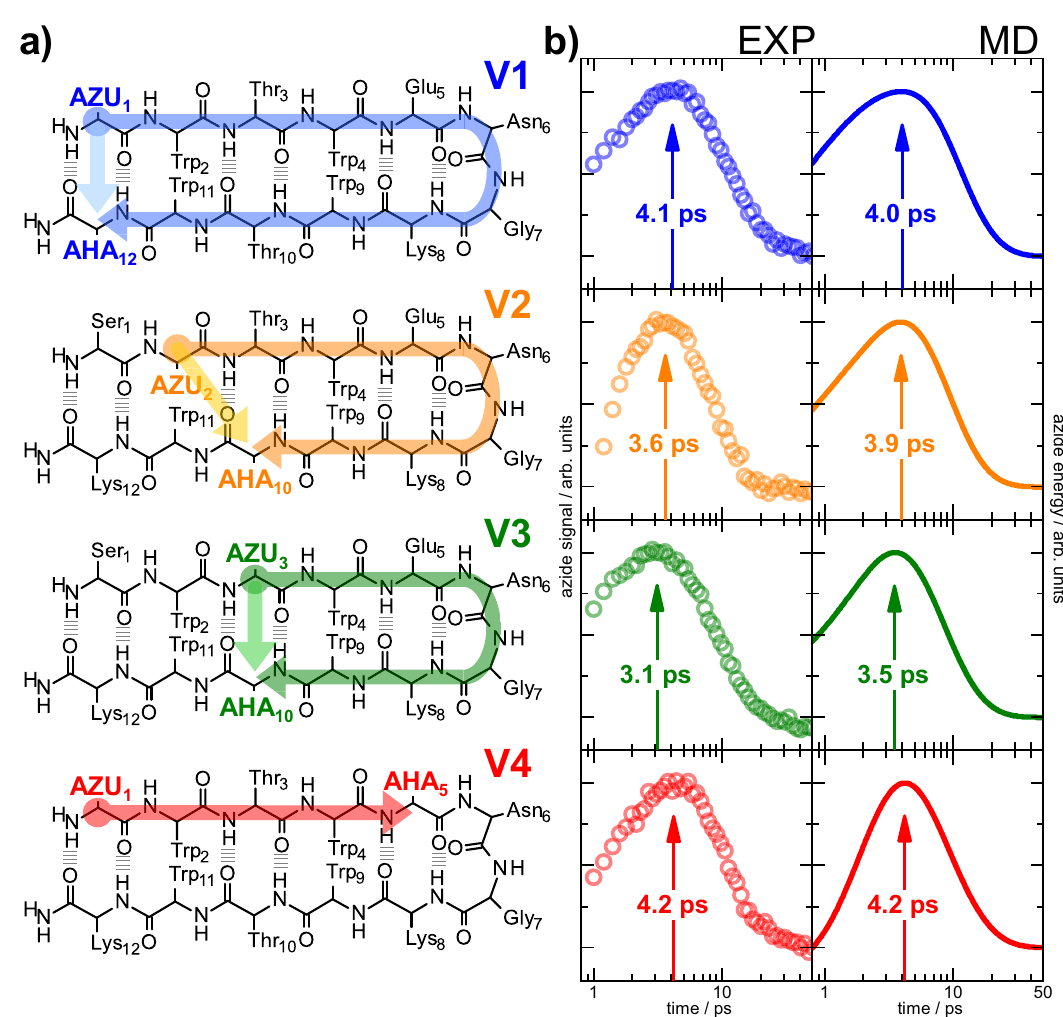
Fig. 2 Overview of the TrpZip2 variants and their measured and computed VET signals. a Scheme of our four TrpZip2 variants V1 – V4. The systematically varied positions of VET donor-sensor pairs in peptide scaffolds are highlighted with the corresponding color. The shortest pathways along and across strands are marked with colored arrows. b VET transients have the same color coding as the TrpZip2 schemes on the left. Arrows indicate the peak times. The panels on the left display the experimentally measured VET transients, while the right panels show the theoretically determined transients using the rate model. Source data are provided as a Source Data fi